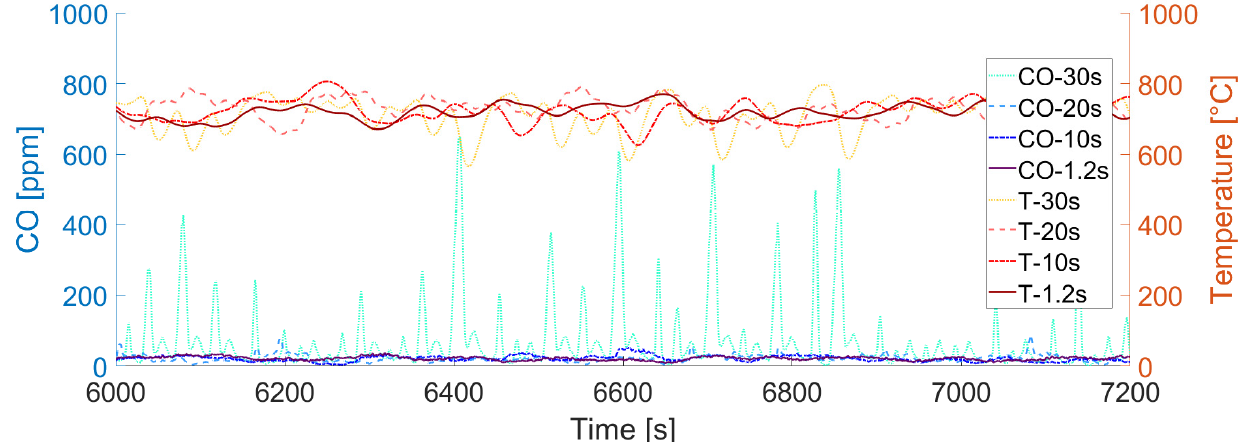
Figure 10. Combustion chamber temperature (T) and CO emissions (CO) after 6000 s of operation (4 kW input power) including a statistical pellet feed function. Pellet feed every 1 s, 10 s, 20 s and 30 s on average.